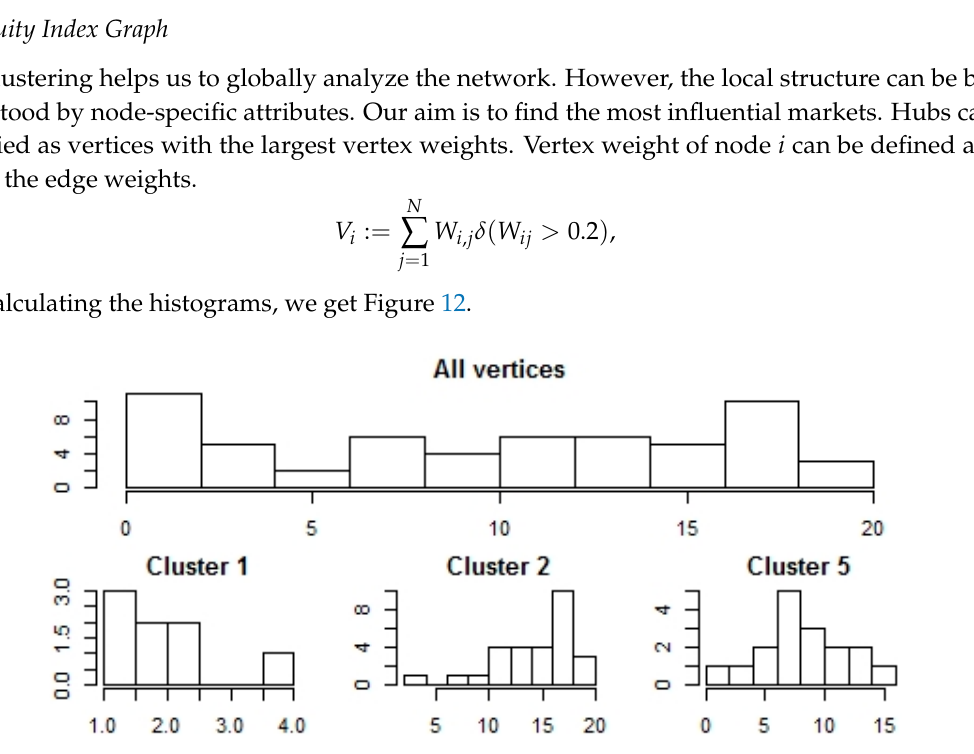
Figure 12. Histogram of vertex weights, five Gaussian cluster, two nodes are connected if their Gaussian similarity is stronger than 0.2.